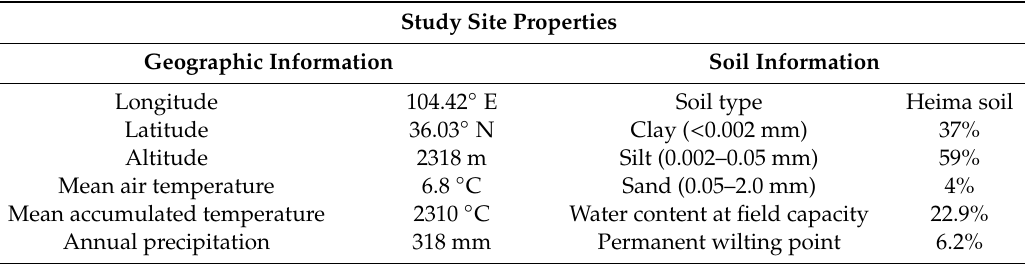
Table 1. Brief description of the experimental site.